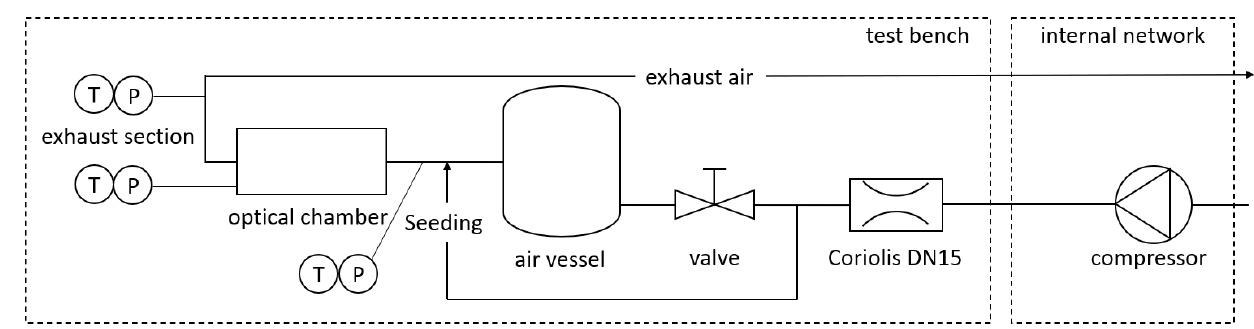
Figure 3. Piping and instrumentation diagram of the optical test bench, showing pressure supply, measurement equipment, air vessel, seeding implementation, optical chamber, and exhaust section.